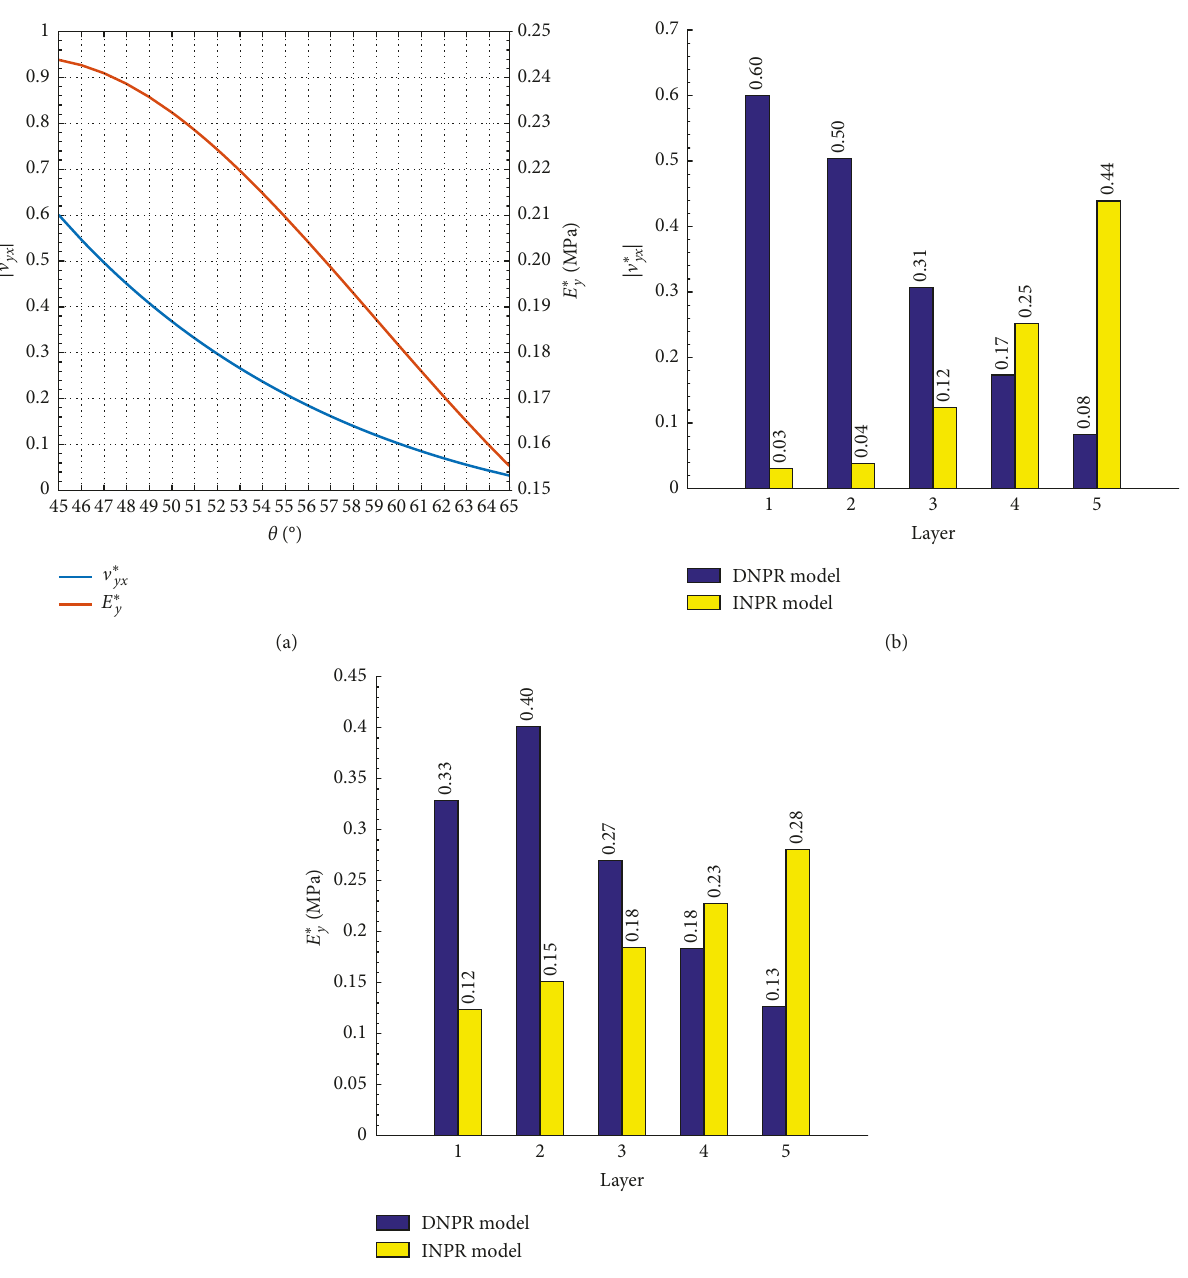
Figure 3: Mechanical indices: (a) | ] ∗ | and E ∗ within the uniform DAH sandwich models; (b) | ] ∗ yx | within gradient DAH sandwich models 6 yx y within gradient DAH sandwich models 6 and and 7; (c) E ∗ y